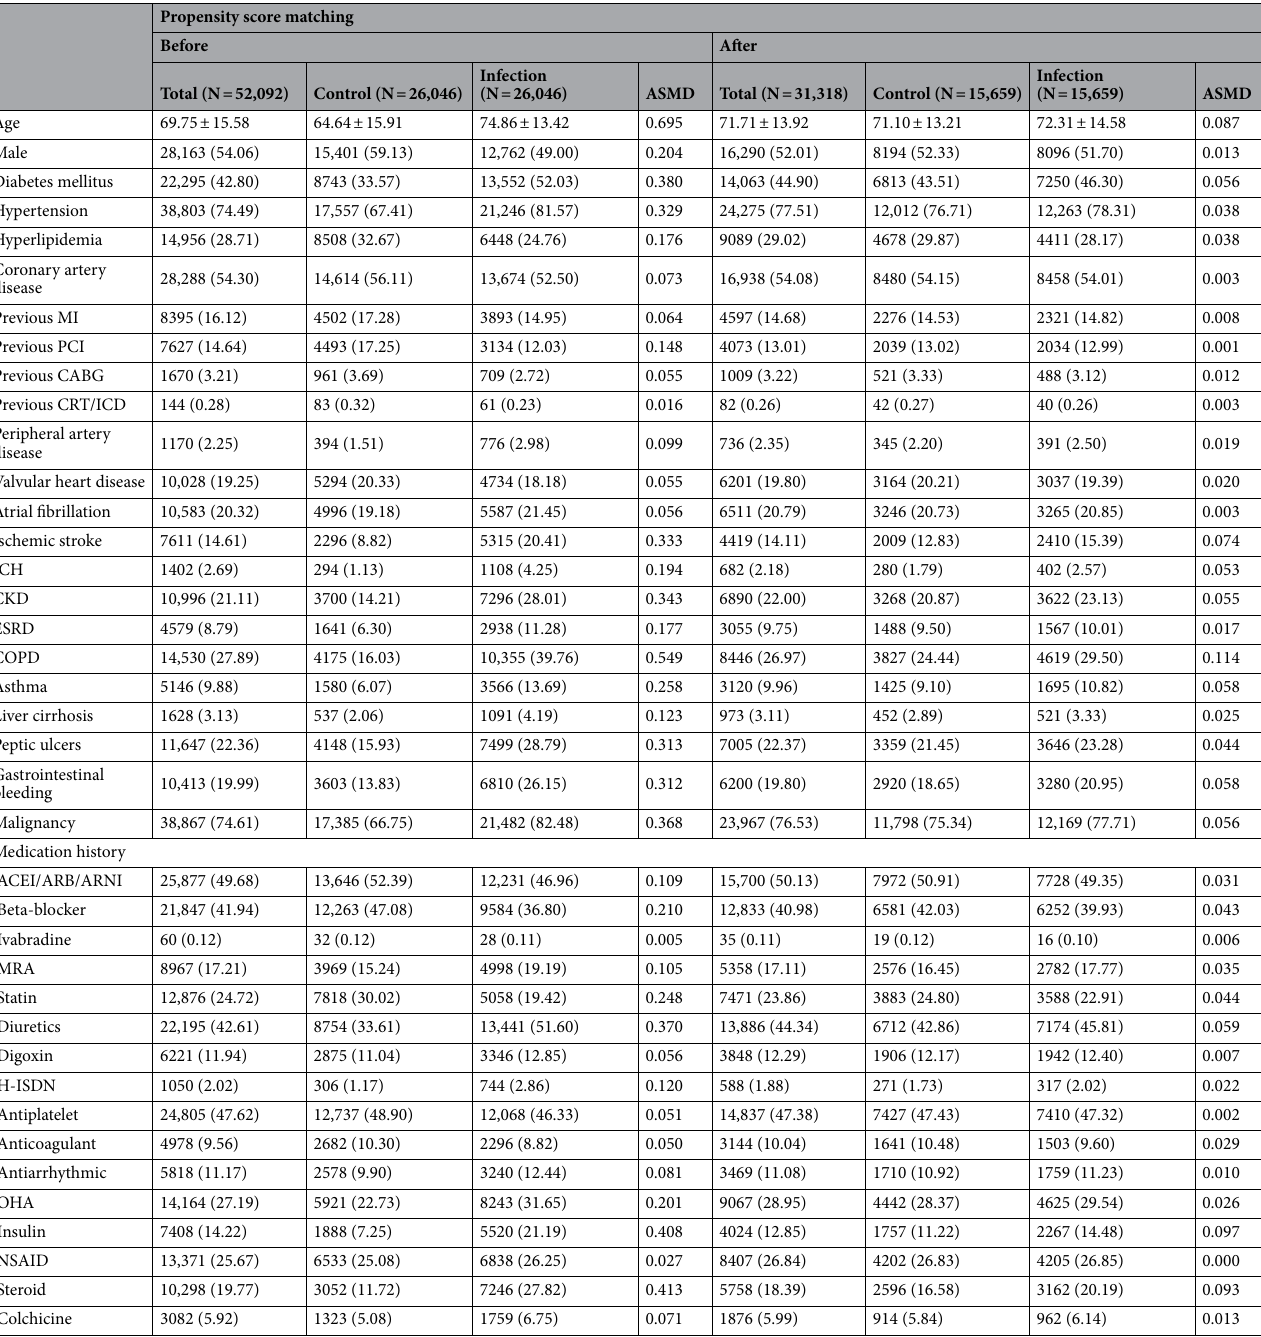
Table 1. Patient characteristics at baseline and after propensity score matching. ASMD absolute standardized mean difference, MI myocardial infarction, PCI percutaneous coronary intervention, CABG